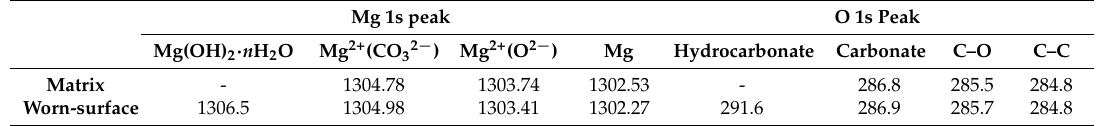
Table 2. Atomic percentage of the C 1s, Mg 1s, O 1s before and after sliding friction. Table 3. Binding energies (eV) of C 1s, Mg 1s, and O 1s peaks and their atomic percentages before and after sliding